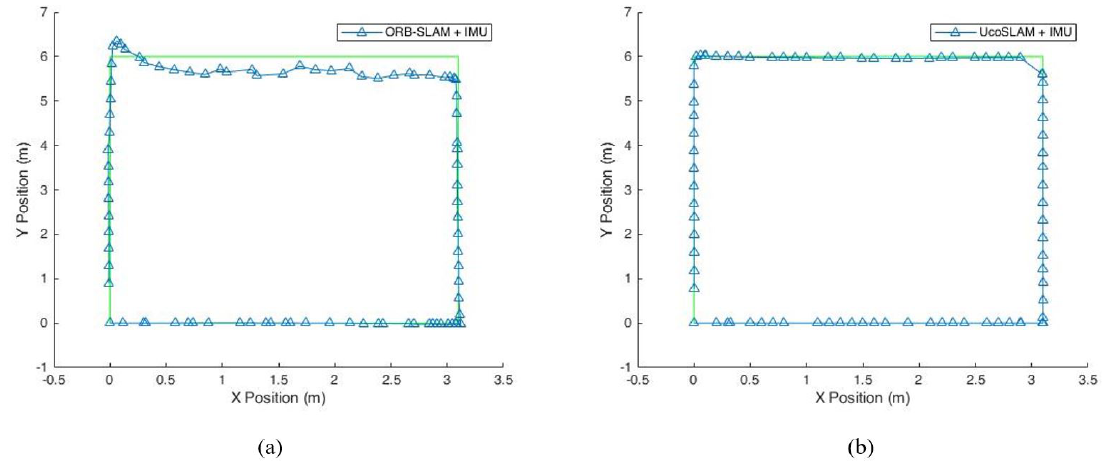
Figure 5. Proposed hybrid systems. ( a ) ORB-SLAM + IMU. ( b ) UcoSLAM +